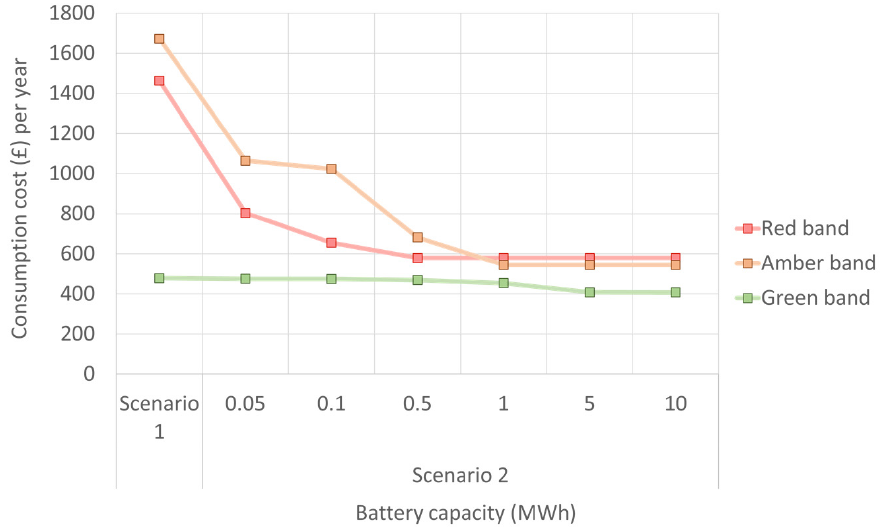
Figure 13. Network consumption cost per year for scenario 1 and scenario 2.